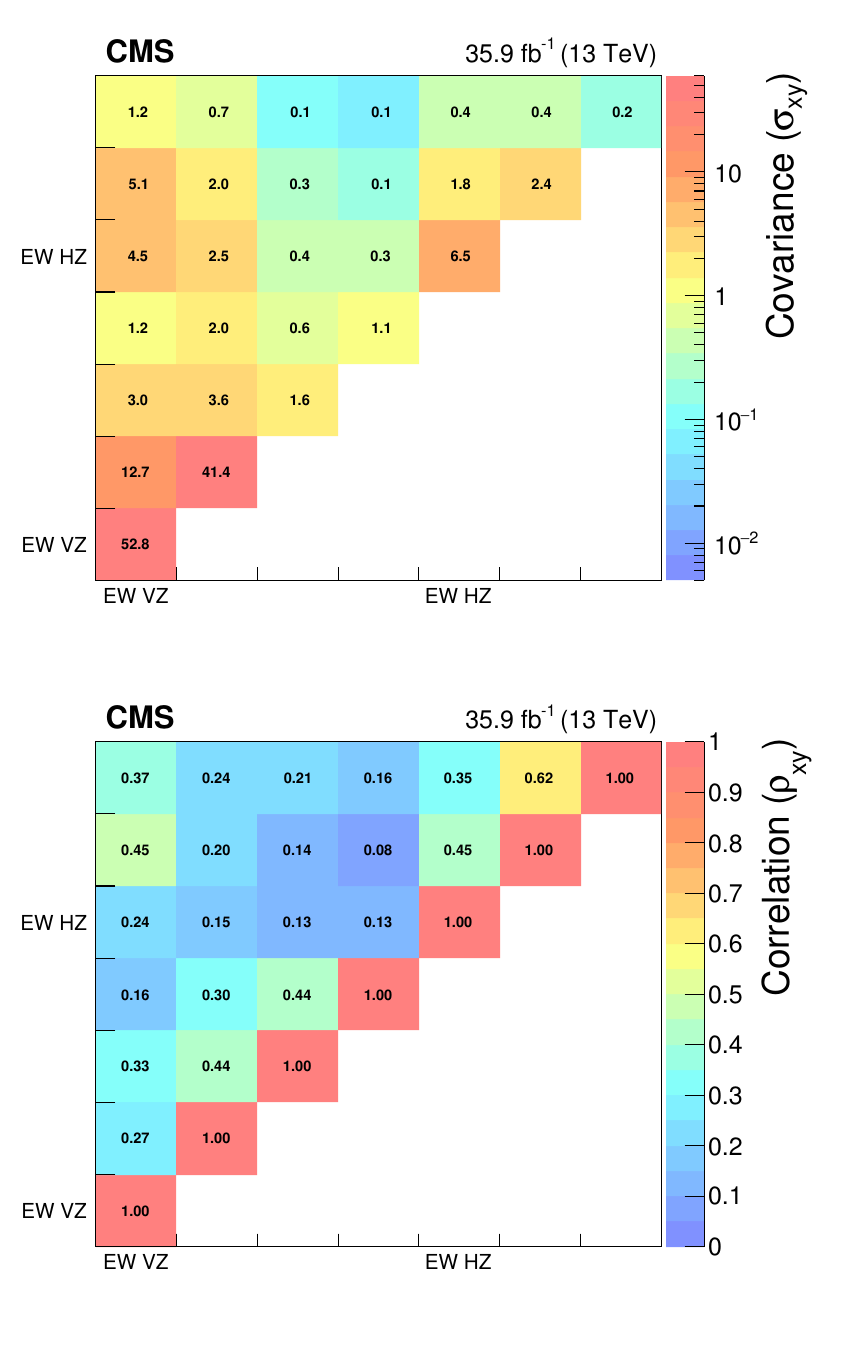
Figure 12 . The covariance (upper) and correlation (lower) matrices for the background predictions in the on-Z EW-production SRs. Within each SR, the individual p miss order starting from 100 GeV. The matrices are symmetric, but only the entries along and above the diagonal are shown for simplicity.